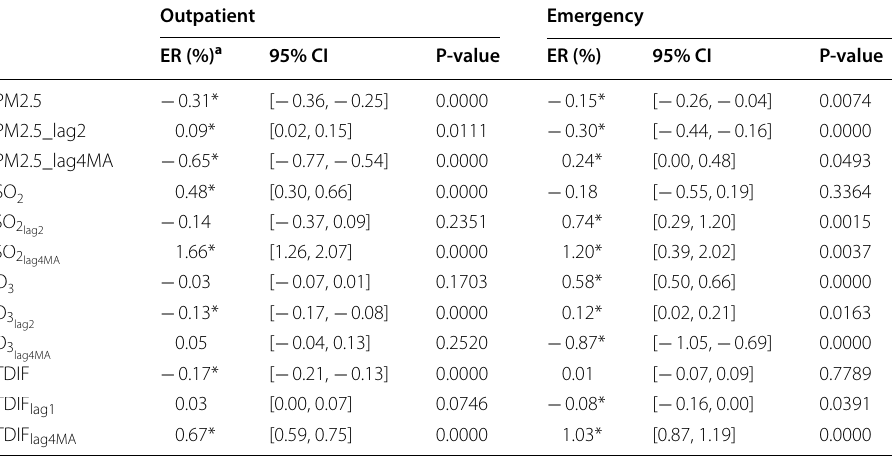
* Significance level, p < 0.05